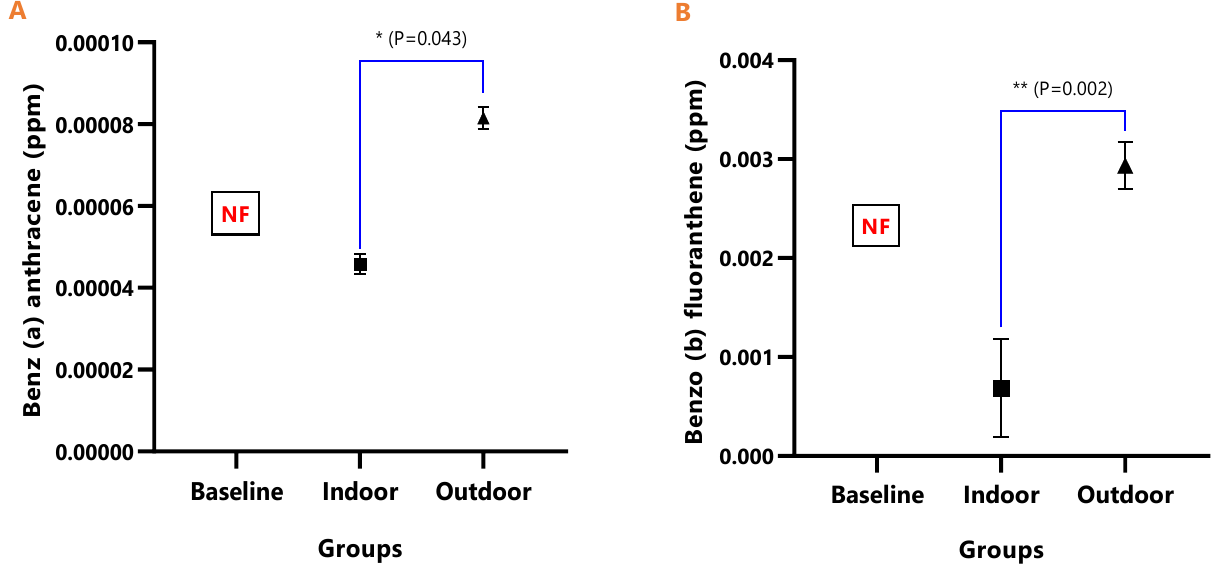
Figure 6. The mean concentrations and test of mean difference for ( A ) Benz (a) anthracene and ( B ) Benzo (b) fluoranthene in the various animal groups